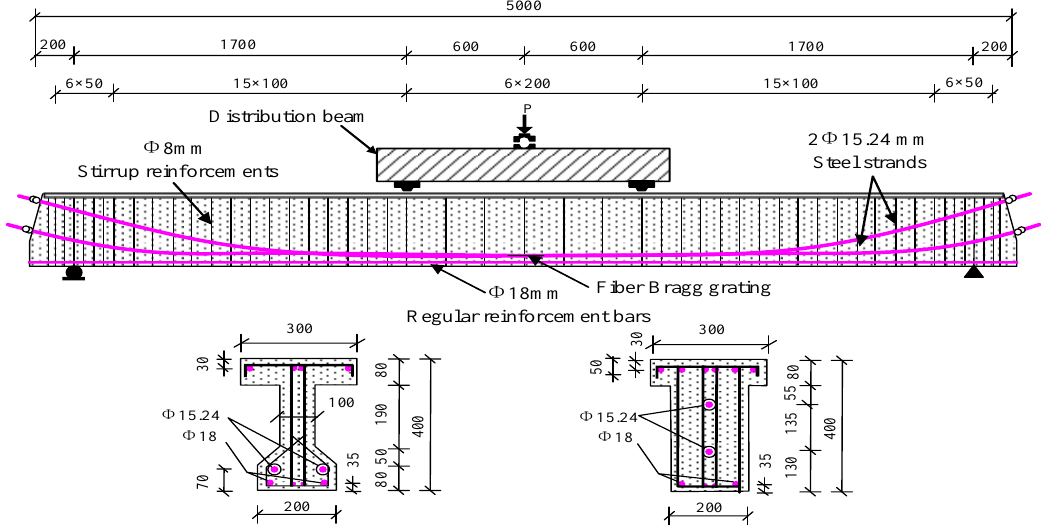
Figure 4. Details and loading diagram of partially prestressed concrete (PPC) beams.